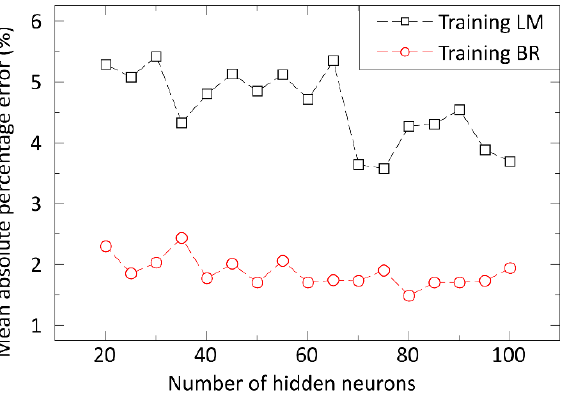
Figure 5. The error of prediction (MAPE) as a function of the number of hidden neurons.